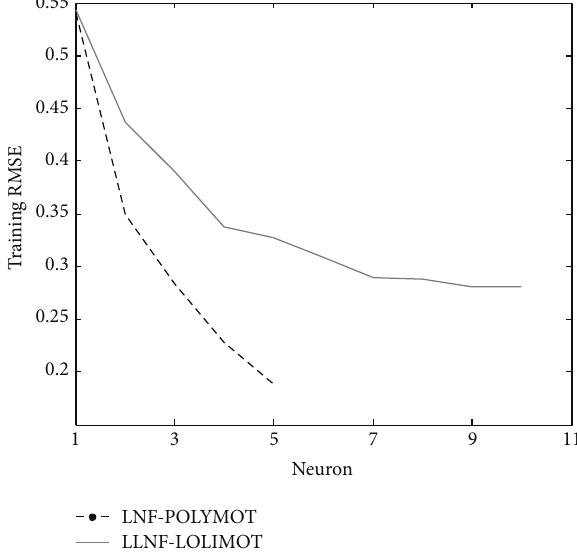
Figure 6: Comparison of training RMSE for LOLIMOT and POLYMOT learning algorithms for first day in April 2010.